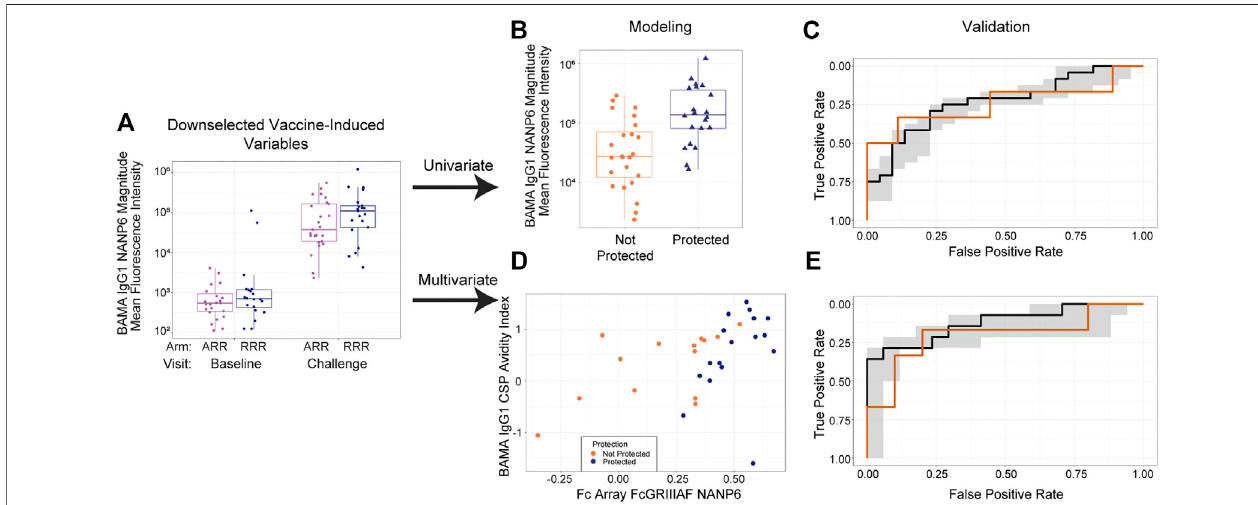
FIGURE 2 | Overall analysis strategy, consisting of (A) down selection, (B) univariate modeling followed by (C) validation and (D) multivariate modeling followed by (E) validation. (A) Boxplotshowing IgG1anti-NANP6bindingantibodyresponsesatbaselineand at challenge inMAL068. Purple dots (cid:1) ARRarm; bluedots (cid:1) RRRarm (B) Boxplot showing day of challenge IgG1 anti-NANP6 binding antibody responses separately by post-challenge outcome status (not protected vs protected) in MAL068. (C) Univariate model trained on all MAL068 data predicting challenge outcomes in the MAL071 RRR arm as a function of day of challenge IgG1 anti- NANP6 binding antibody responses (D) Scatter plot of day-of-challenge BAMA IgG1 CSP Avidity Index and Fc Array FcGRIIIAF NANP6 binding in MAL068, with points coloredbyprotectionstatus(orange (cid:1) notprotected,blue (cid:1) protected). (E) Best-performingtwo-variableadditivemodeltrainedonallMAL068datapredictingchallenge outcomes in the MAL071 RRR arm as a function of day of challenge Fc Array FcGRIIIAF NANP6 binding and BAMA IgG1 CSP Avidity Index. In panels (C) and (E) , the blacklineisthemedian ROCcurve from cross-validation on allMAL068 data,the gray shaded areaisthe 95%empirical interval for theROC curve from cross-validation on all MAL068 data, and the orange line is the ROC curve for predicting MAL071 RRR arm data. BAMA (cid:1) binding antibody multiplex assay.